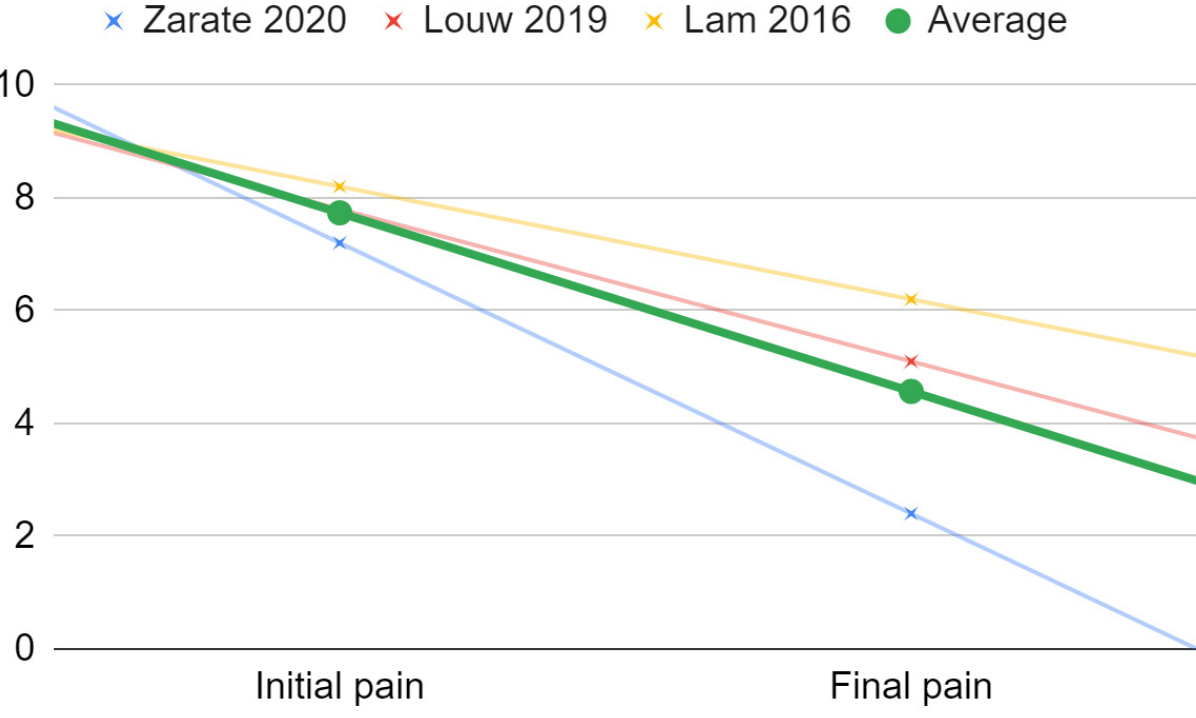
Figure 6. Linear regression model of pain intensity in dextrose and lidocaine therapy.